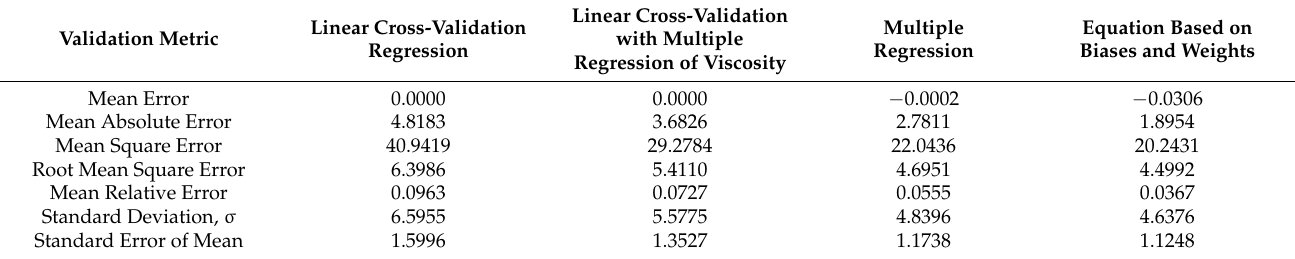
Table 9. Assessment of best alternative equations with different validation metrics for hardness calculation. Validation